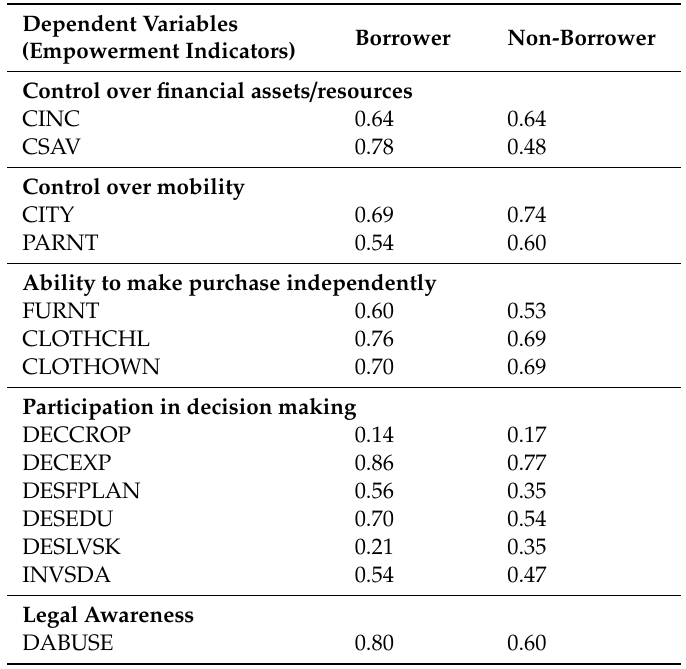
Table 8. Predicted probabilities of rural women empowerment in borrower and non-borrower